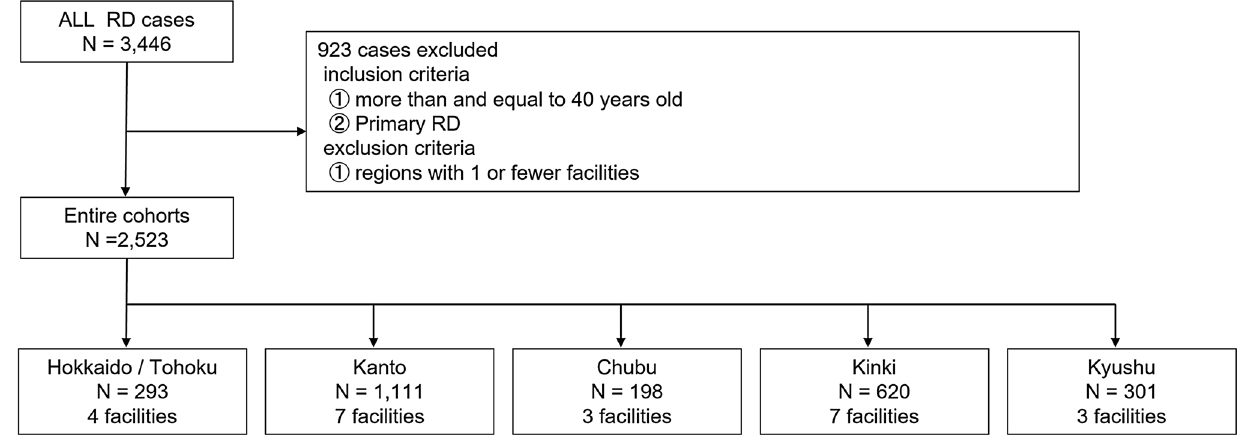
Figure 2. Flow chart describing selecting the study population. RD, retinal